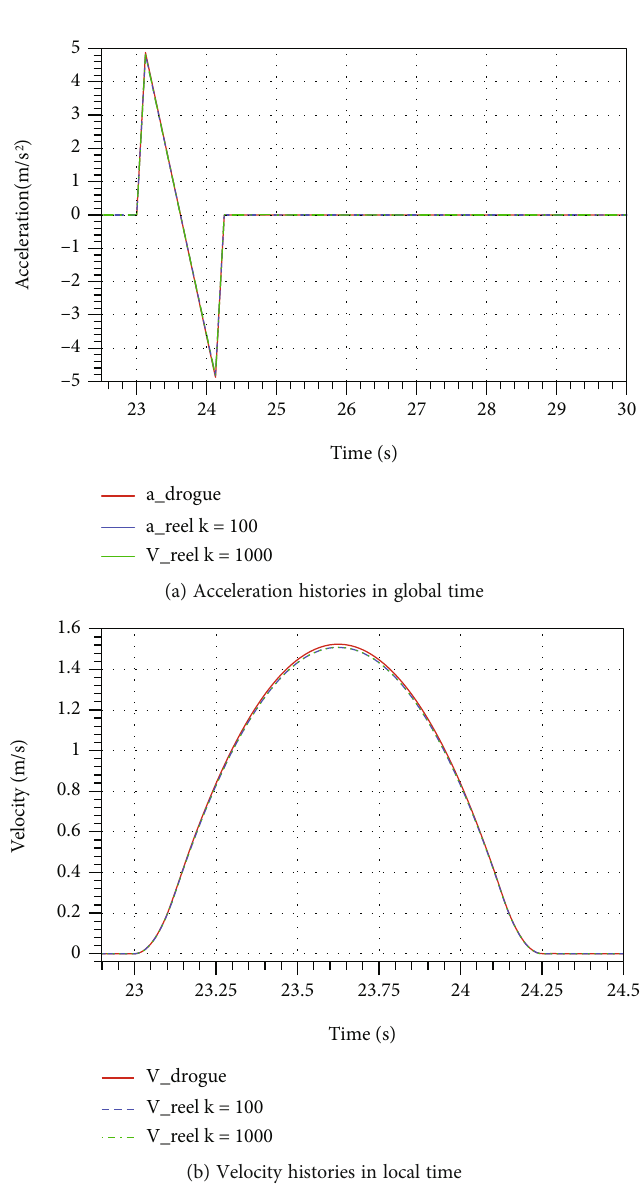
Figure 14: Case W4bE0-k velocity and acceleration histories with di ff erent k = 4 : 877 m/s 2 is used. Figure 12 shows the acceleration a drogue and velocity histories of the drogue and reel, respectively.